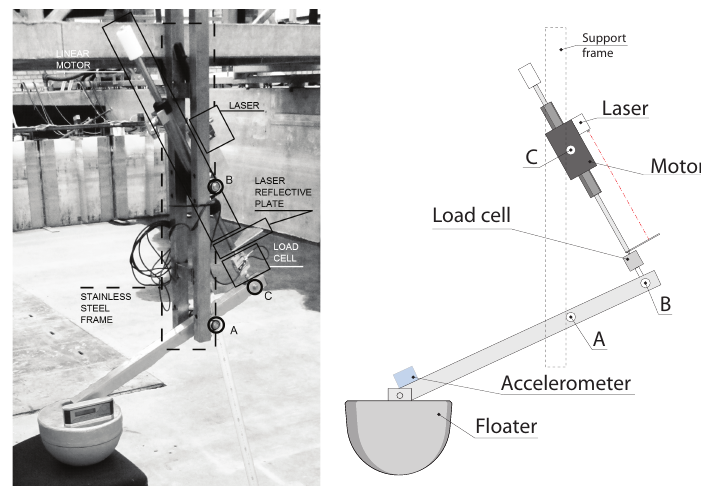
Figure 7. 1:20 physical model of a Wavestar single floater with annexed